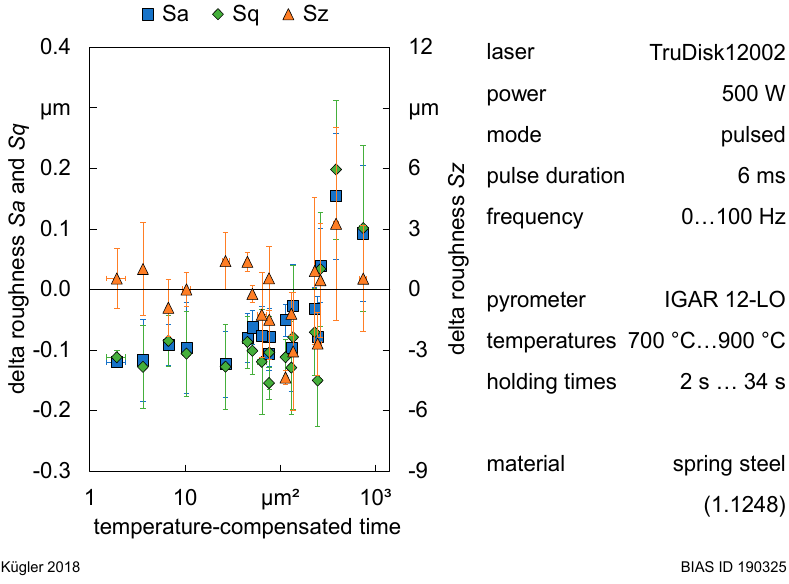
Figure 5. Roughness values Sa , Sq , and Sz of laser-heated 1.1248 sheets.